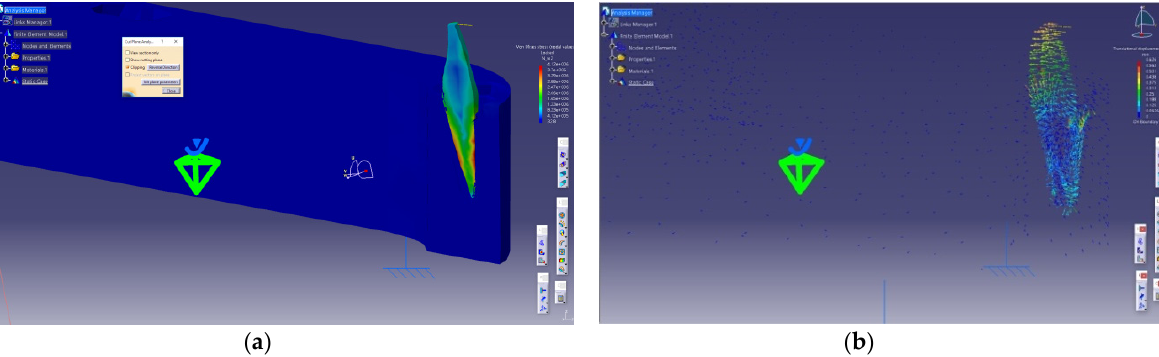
Figure 5. Lingualization of the LCI using a 3 N force: ( a ) von Mises tensions, no HBL; ( b ) tooth movement obtained, no HBL.